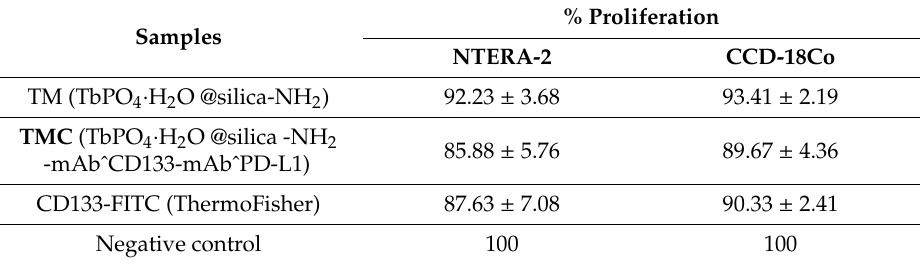
Table 2. The e ff ects of TMC on the proliferation of NTERA-2 and CCD-18Co Table 2. The effects of TMC on the proliferation of NTERA-2 and CCD-18Co cells Samples